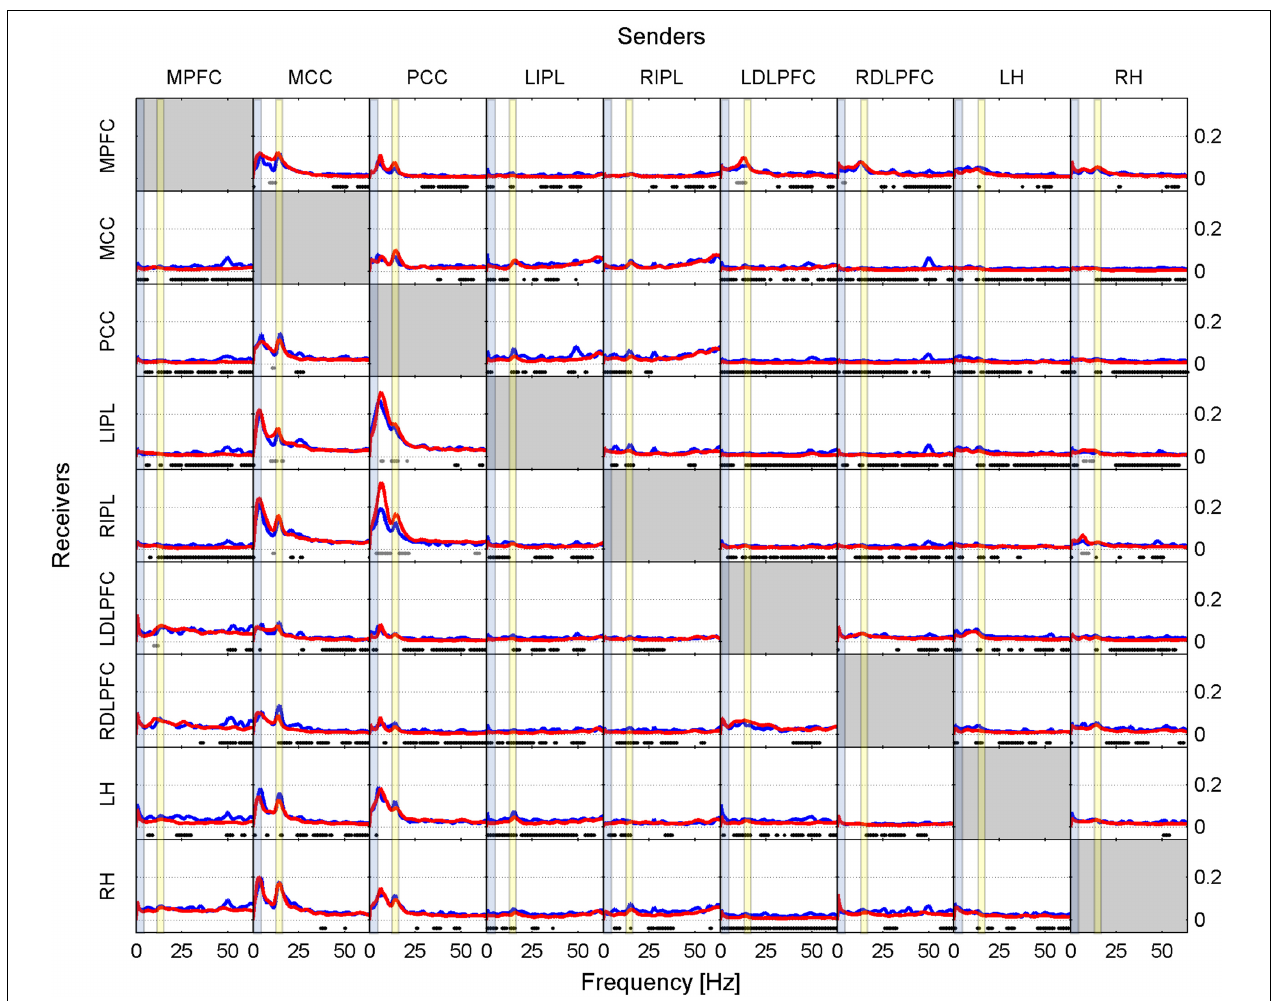
FIGURE 3 | Effective connectivity assessed by iCOH after the SOn transition in baseline (blue curves) and recovery (red curves). For details of the representation see Figure 1 . Dots below the curves indicate significant differences between iCOH after SOn in baseline vs. iCOH after SOn in recovery: gray dots iCOH recovery > iCOH baseline; black dots iCOH recovery < iCOH baseline. To facilitate orientation, the delta (0.5–5 Hz)) and sigma (12–16 Hz) band have been highlighted by light blue and light yellow,